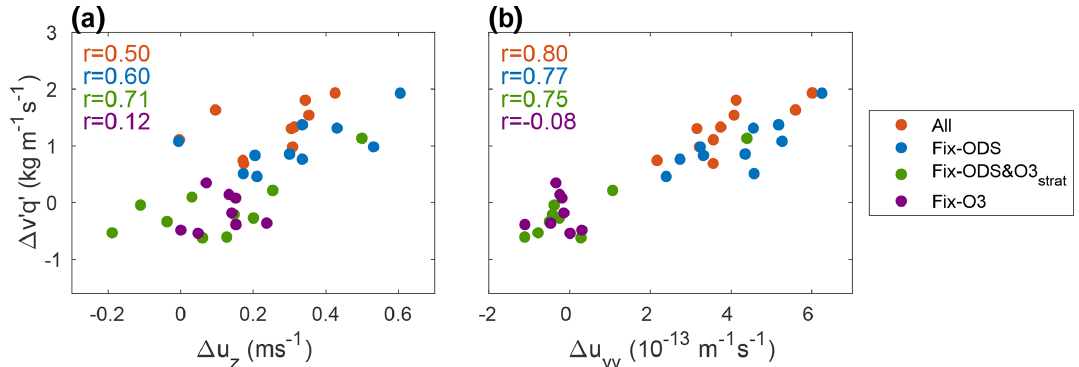
Figure 8. The response over the second half of the 20th century forcing of the DJF midlatitude to high-latitude eddy moisture flux ( (cid:49)v (cid:48) q (cid:48) ) as a function of (a) the vertical shear of the zonal wind ( (cid:49)u z ) and (b) the meridional gradient of the mean relative vorticity ( (cid:49)u y y ) in the full forcing ensemble (All, red), fixed ODS ensemble (Fix-ODS, blue), fixed ODS and stratospheric ozone ensemble (Fix-ODS&O3 strat , green), and fixed stratospheric and tropospheric ozone ensemble (Fix-O3, purple). Correlations appear in the upper left corner of each